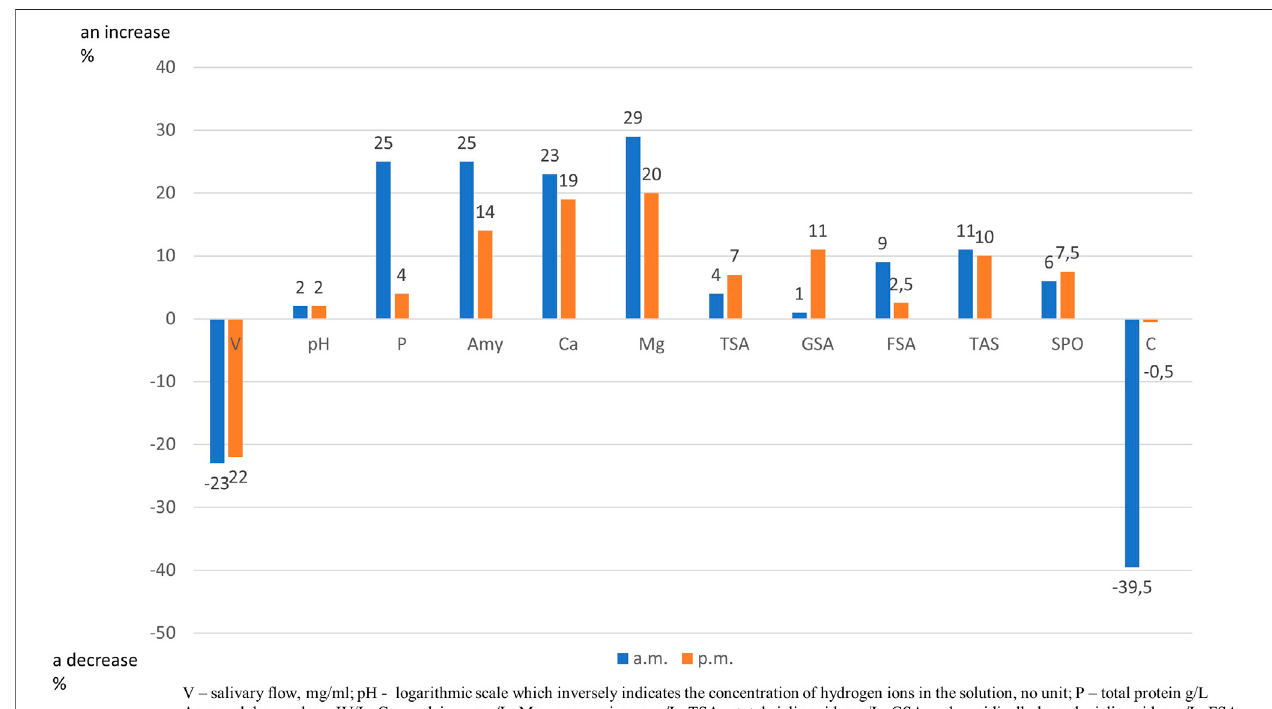
FIGURE1| Effect oftrainning session onrelative changesinsalivary parameters. “ Zero ” isset as100%levelofsalivaryparametersbeforetrainning session and an increase or a decrease is expressed as percentage.